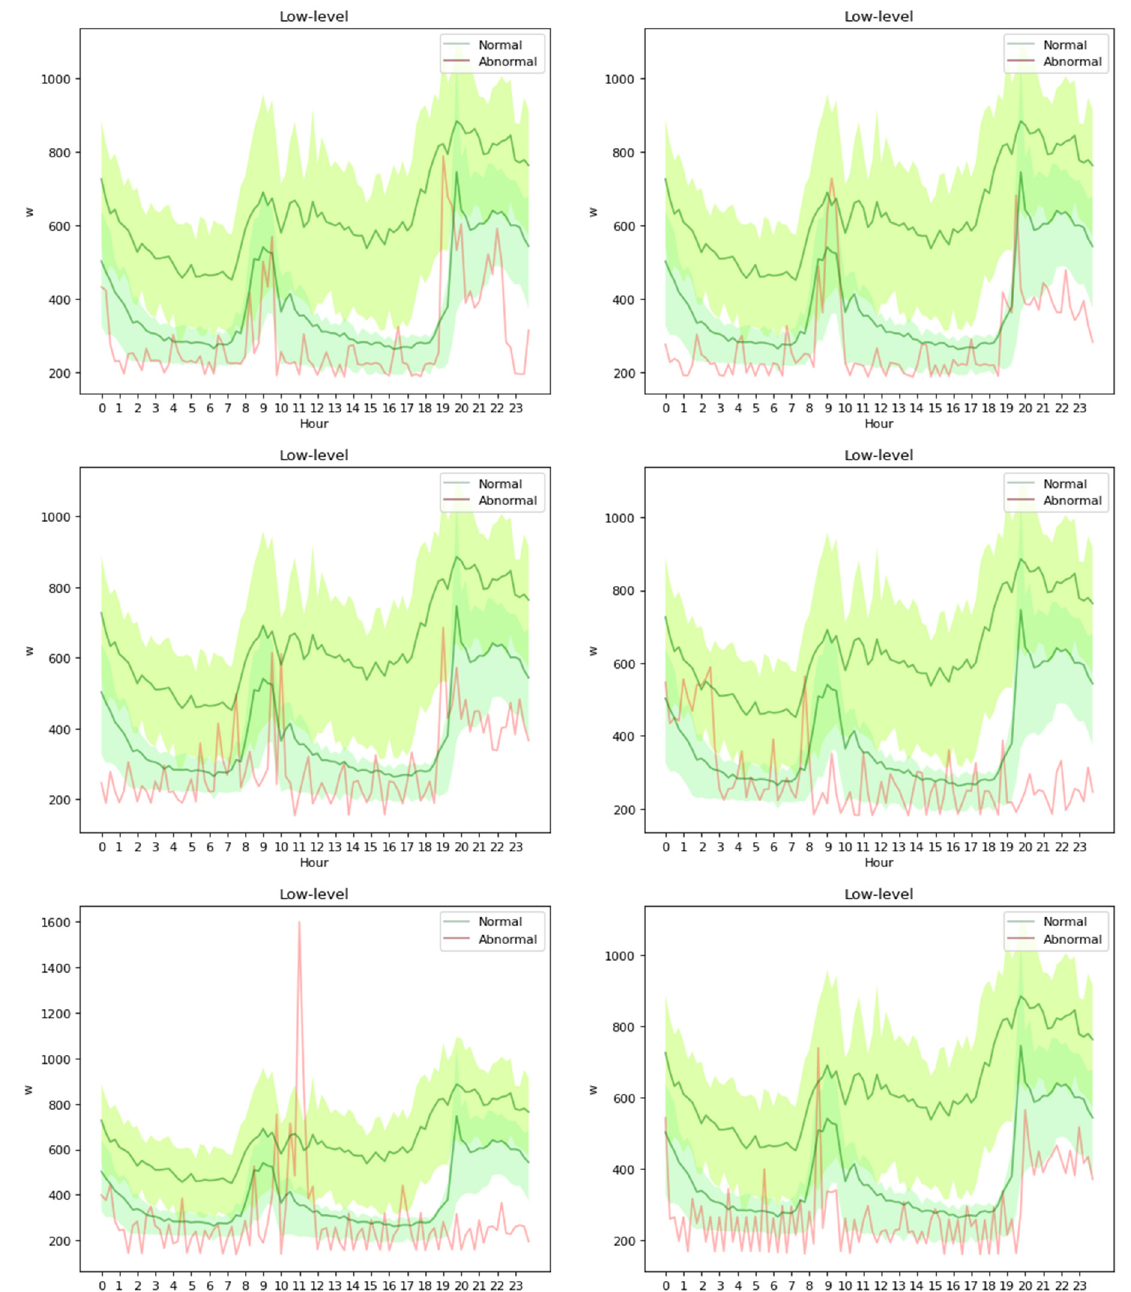
Figure A5. Load profiles of each abnormal electricity consumption events of User 03 using the low-level features.